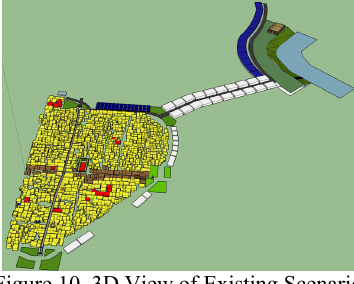
Figure 10. 3D View of Existing Scenario